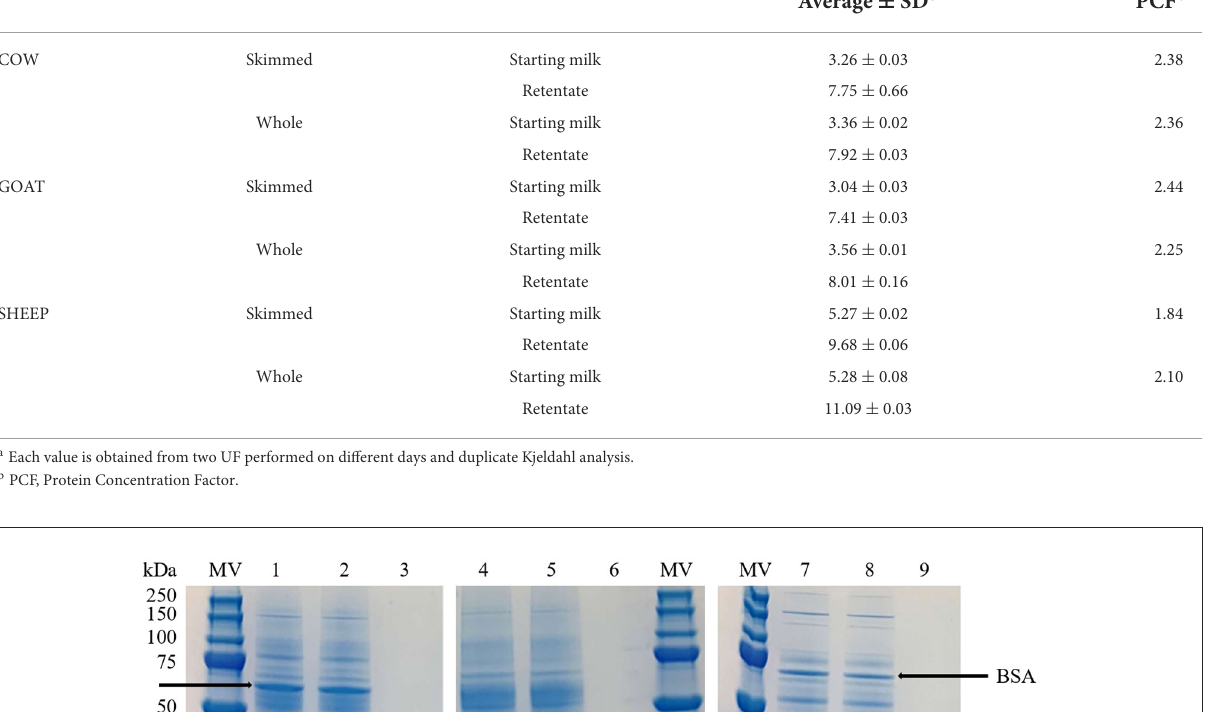
TABLE 2 Total protein content (g/100mL) of cow, goat and sheep milk, before and after ultrafiltration (UF), determined by Kjeldahl.